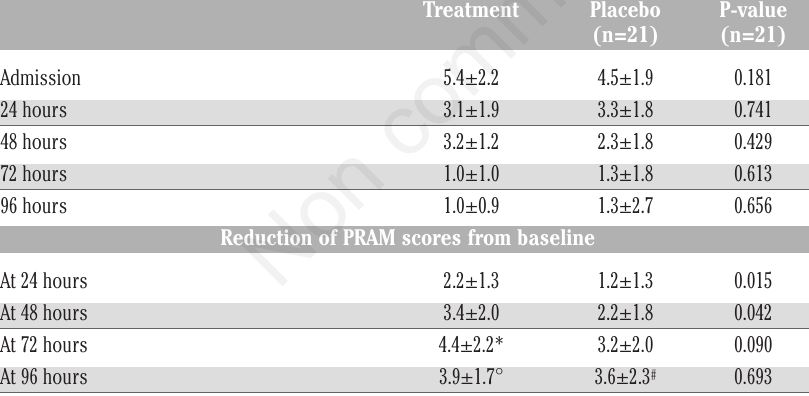
Table 2. Pediatric respiratory assessment measure severity scores during study.